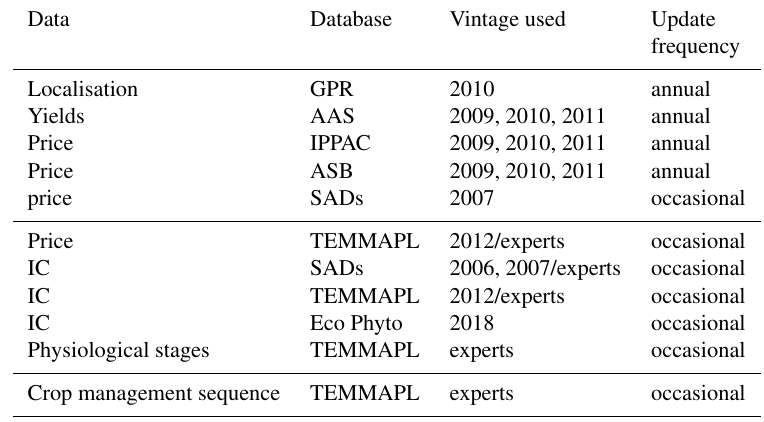
Table 10. Vintage and update frequency of database used to apply floodam.agri at the national scale in